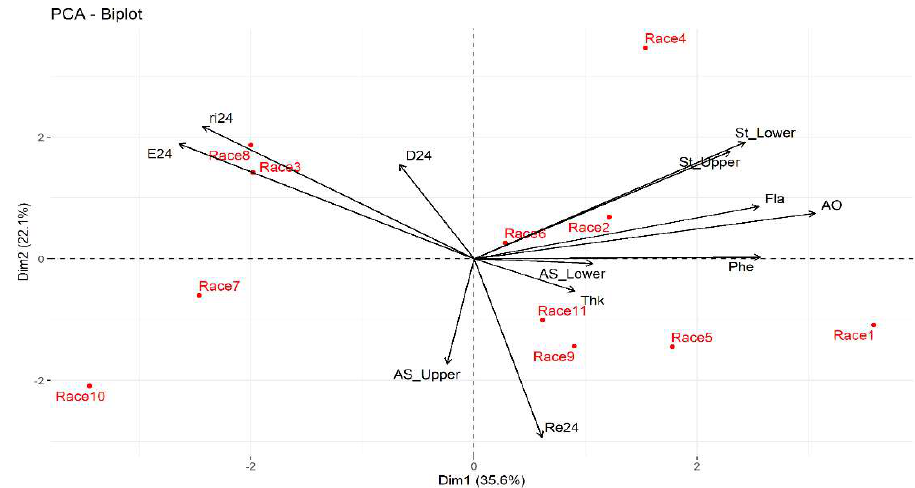
Figure 2. Biplot of the first two principal components of the thirteen variables and 11 maize races at 24 h under laboratory conditions. Race 1—Raton; Race 2—Olotillo; Race 3—Tuxpeño Norteño; Race 4—Bolita × Raton; Race 5—Elotes Occidentales × Tuxpeño; Race 6—Tabloncillo × Tuxpeño; Race 7—Chalqueño × Tuxpeño; Race 8—Celaya; Race 9—Vandeño; Race 10—Nal Tel × Raton;